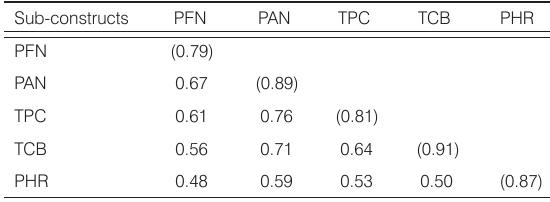
Table 5. Convergent validity and discriminant